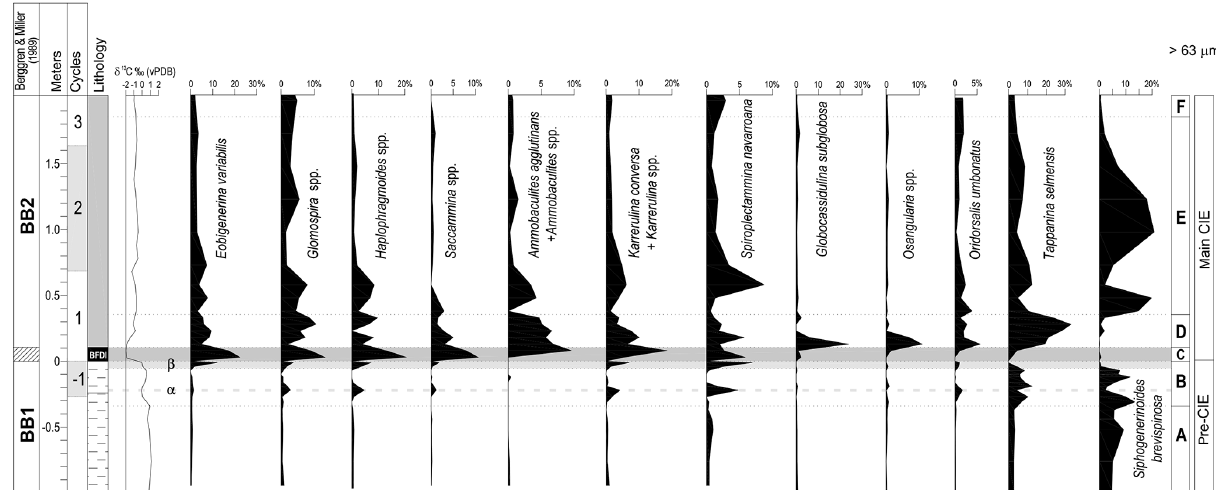
Figure 7. Enlargement of the interval from − 1 to + 2m across the Paleocene–Eocene boundary at Forada showing the relative abun- dance of selected benthic foraminifera plotted against biostratigraphy, precessional cycles, lithology, δ 13 C bulk record, recognized benthic foraminiferal assemblages (A to F) and isotopic intervals. Benthic foraminiferal biozonation after Berggren and Miller (1989). The gray bands indicate intervals of carbonate dissolution. α : pre-CIE dissolution interval; β : burndown layer; BFDI: benthic foraminiferal dissolu- tion interval.